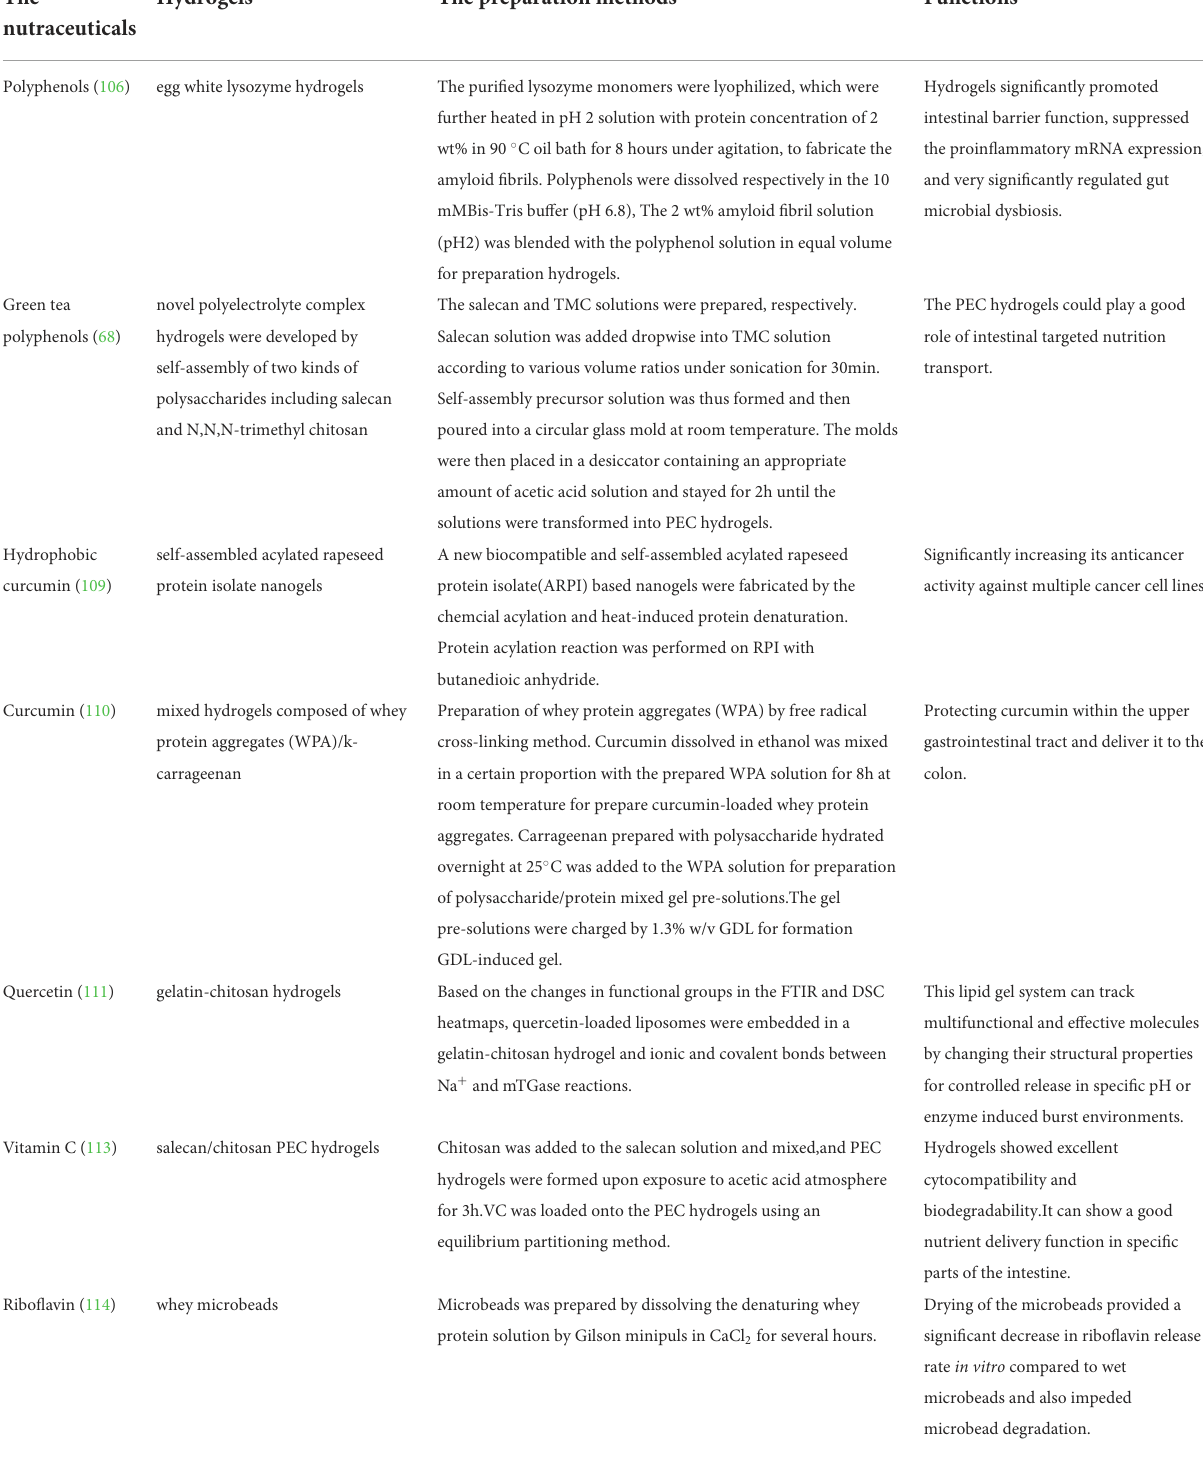
TABLE 1 The preparation method of different hydrogels for encapsulation and delivery of nutraceuticals including phenolic bioactives, vitamins and probiotics, as well as their functions.